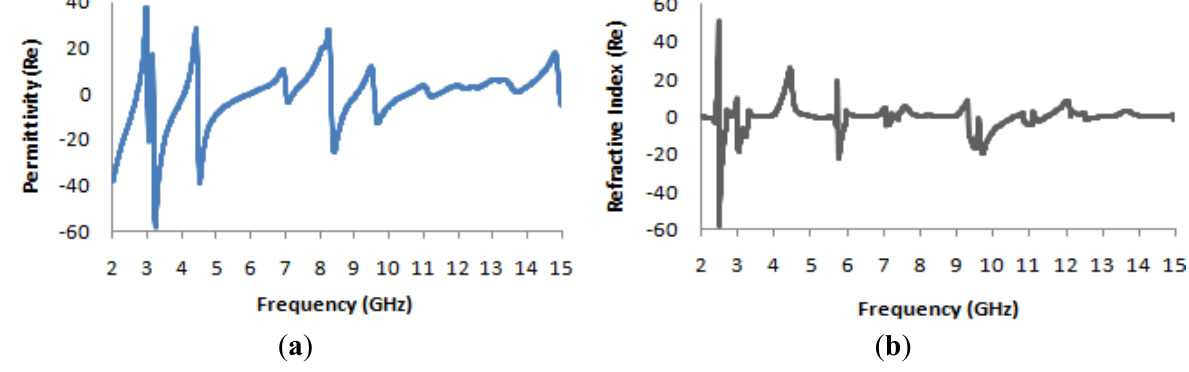
Figure 14. ( a ) The real value of permittivity vs. the frequency for the 2 × 2 array of the unit structure; ( b ) the real value of the refractive index vs. frequency for the 2 × 2 array of the unit